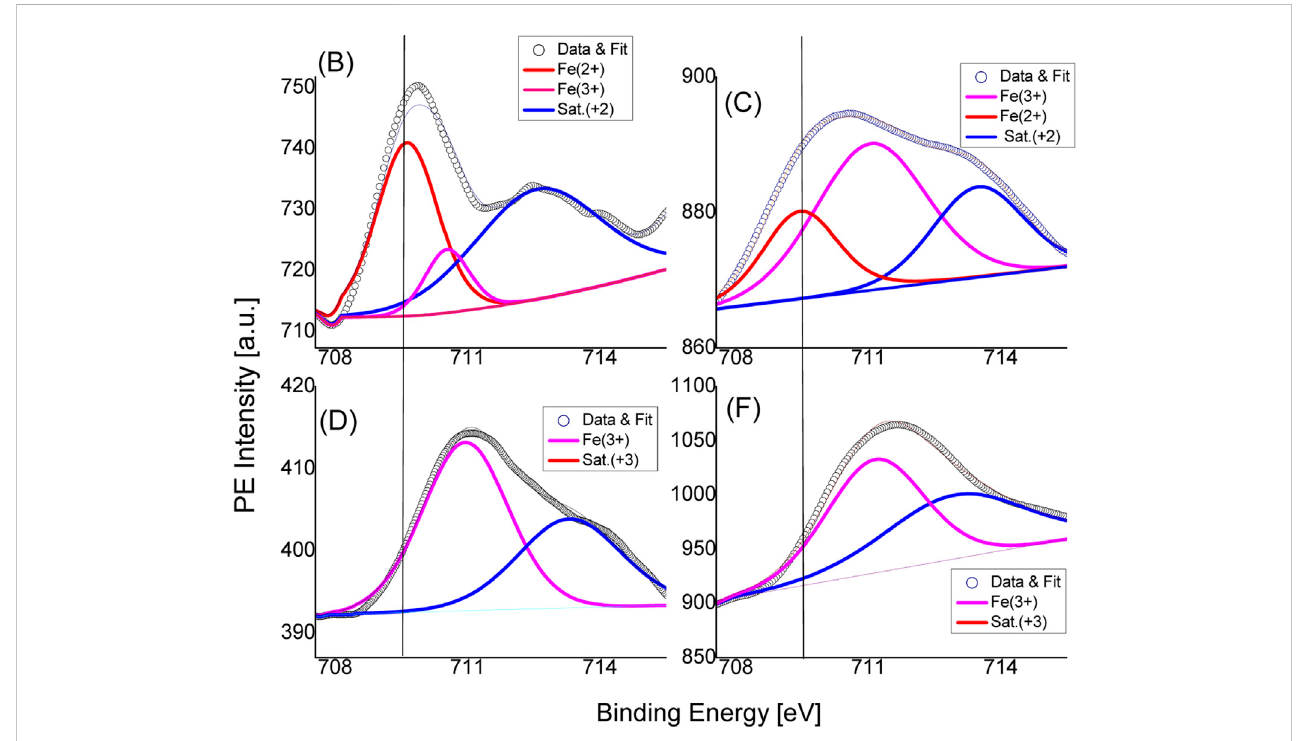
FIGURE 5 Results from X-ray photoelectron spectroscopy for iron-2p electrons, along with their corresponding satellite structures, demonstrate binding energy fl uctuations for Fe 2+ and Fe 3+ oxidation states in a variety of Fe-doped substrates (B – F) .